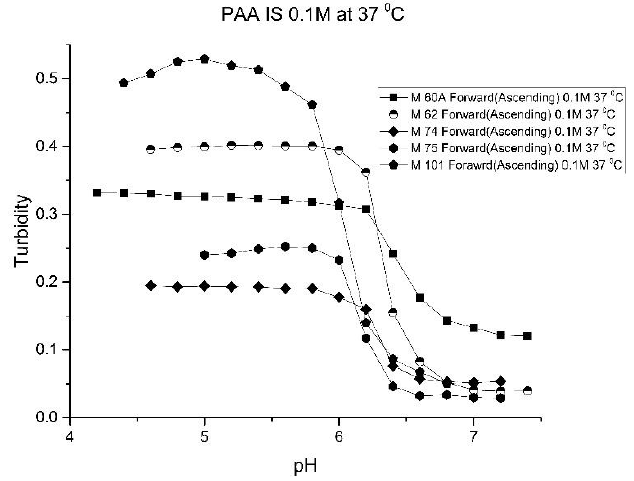
Figure 11. Ascending pH response curves for polymer particles of M-60A, M-62, M-74, M-75, and M-101 at 37 °C . Table 7. Formulations of N -isopropylacrylamide Copolymers of Propacrylic Acid.